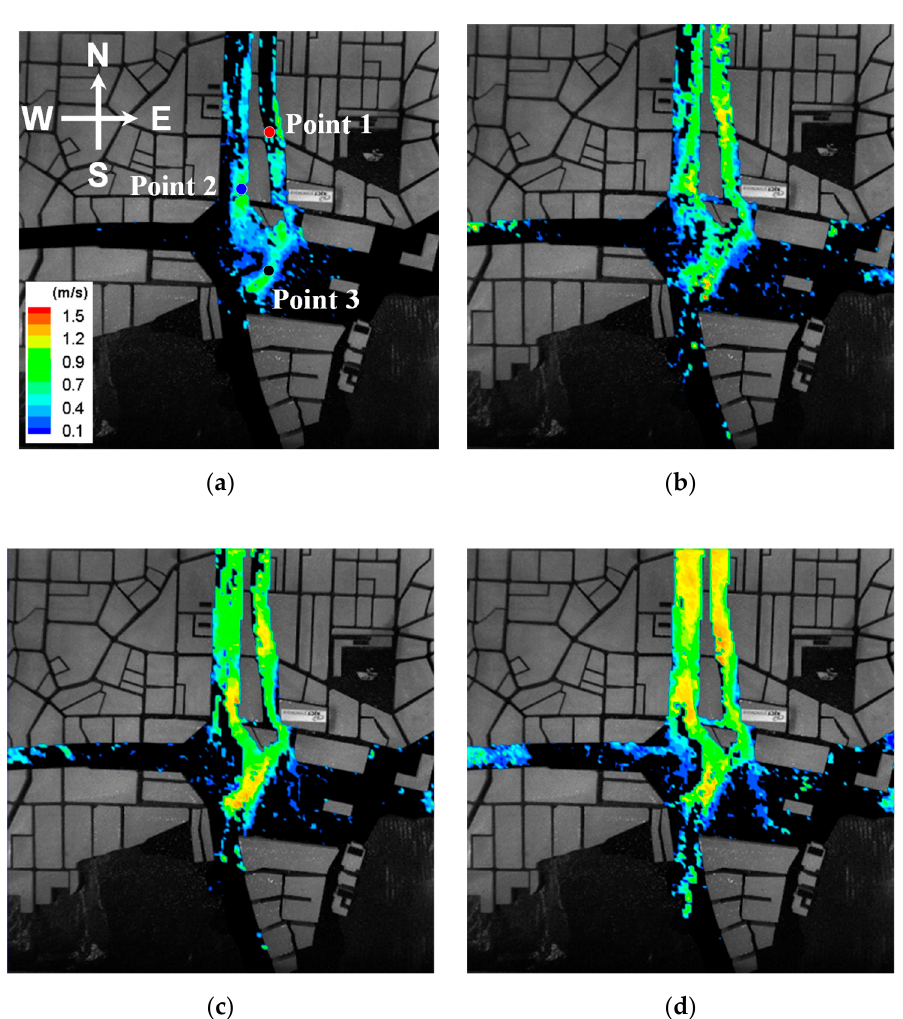
Figure 6. Runo ff velocity distributions according to rainfall intensity: ( a ) 80 mm / h; ( b ) 130 mm / h; ( c ) Figure 6. Runoff velocity distributions according to rainfall intensity: ( a ) 80 mm/h; ( b ) 130 mm/h; ( c ) 160 mm / h; ( d ) 185 mm / 160 mm/h; ( d ) 185 mm/h.